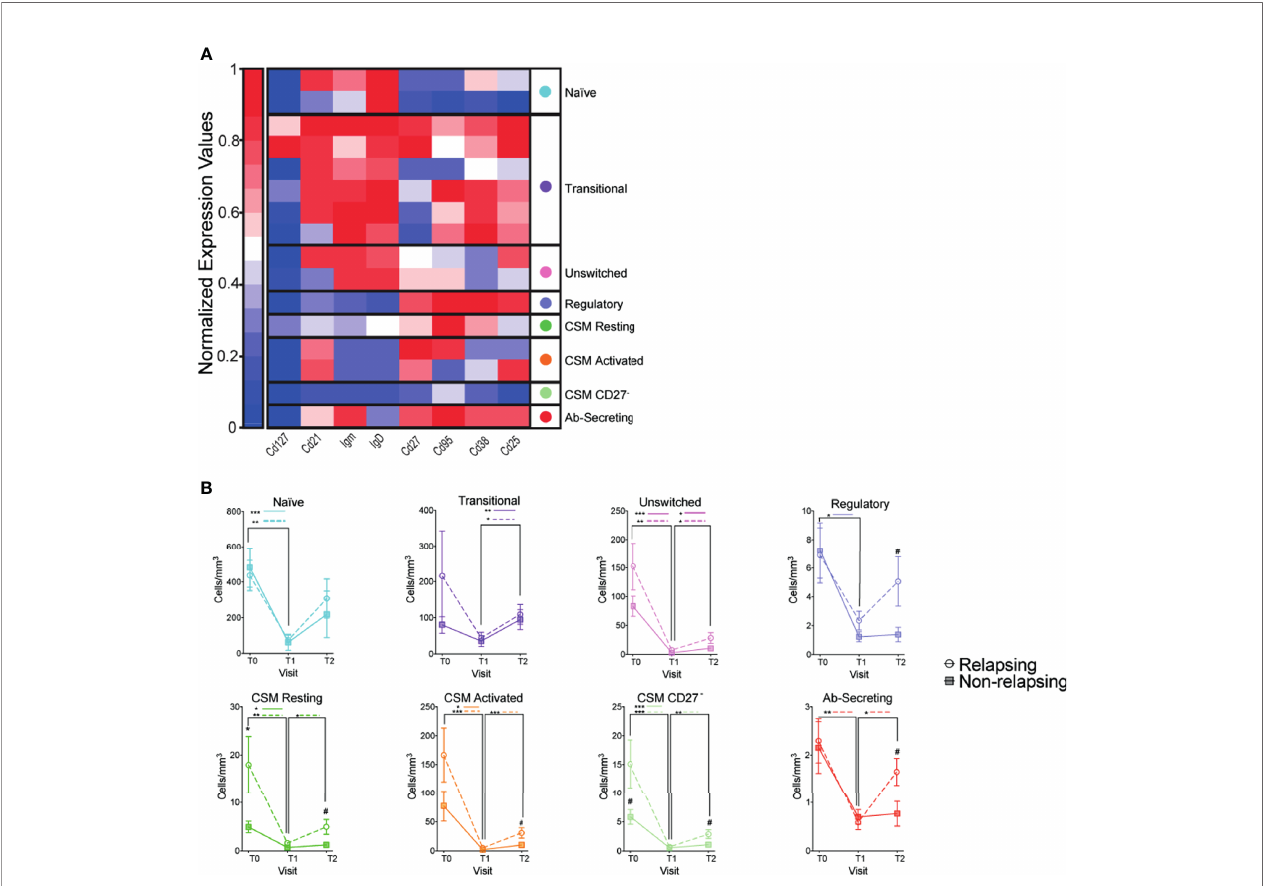
FIGURE 3 | Changes in B cell subsets after anti-CD20 Ab therapy. (A) Heatmap of CD19 + immune cells colored and labeled by Phenograph cluster for all subjects and time points combined (see Methods). Rows represent different clusters identi fi ed and columns the relative expression of each marker in that particular cluster (B) Absolute numbers of CD19 + B cell subsets once demultiplexed and based on the summation of Phenograph clusters before (T0) and serially after (T1 and T2) anti- CD20 therapy. Comparisons between relapsing and non-relapsing at the same timepoint # p < 0.05. Comparisons between different timepoints *p < 0.05, **p < 0.01, ***p < 0.001. Two-way ANOVA corrected for multiple comparisons. Data points depict mean ±